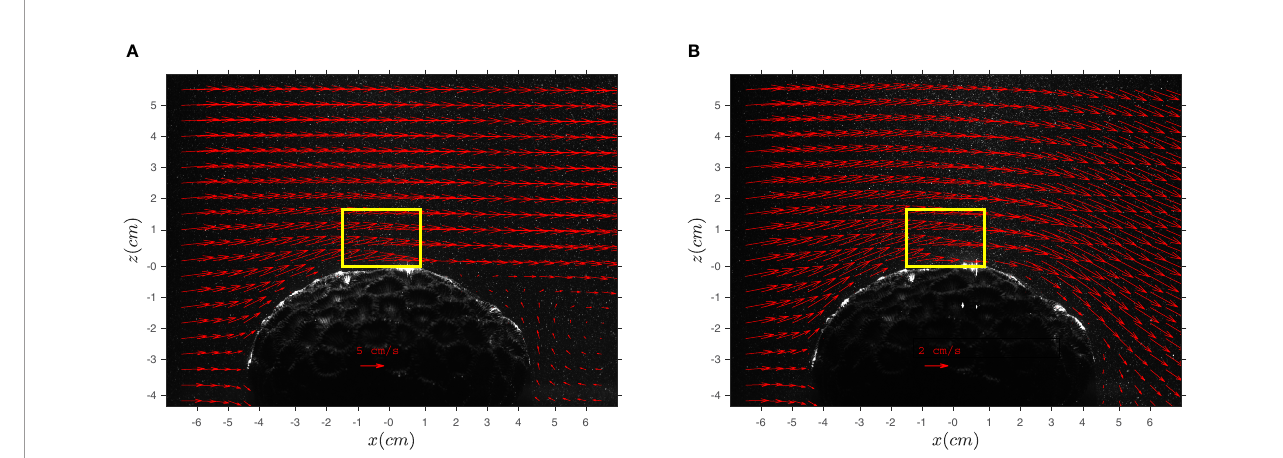
FIGURE 3 | Time average velocities around a skeleton of D. favus under unidirectional (A) and wave (B) fl ow conditions. The fl ow rates were Q = 0.011 m 3 s -1 in (A) and Q = m 3 s -1 in (B) . The yellow rectangular marks the domain size of the PIV measurement used for the analysis shown in Figures 4 and S2